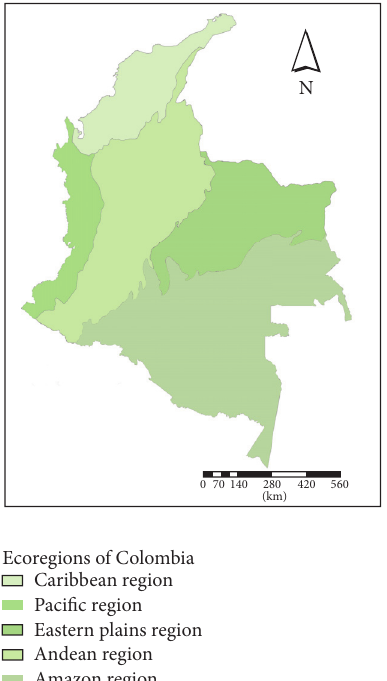
Figure 1: Ecoregions of